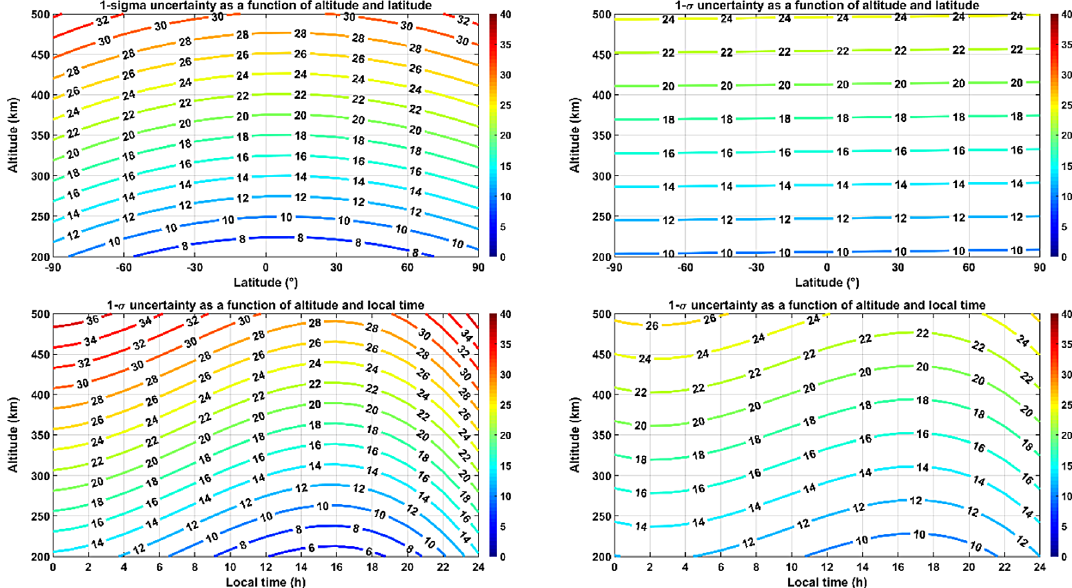
Fig. 11. Contour level plot of the 1- r uncertainty (in percent) as a function of geographical coordinates: (left) Accelerometer uncertainty ’ s model, (right) HASDM uncertainty ’ s model. (Top) altitude and latitude, (bottom) altitude and local time.